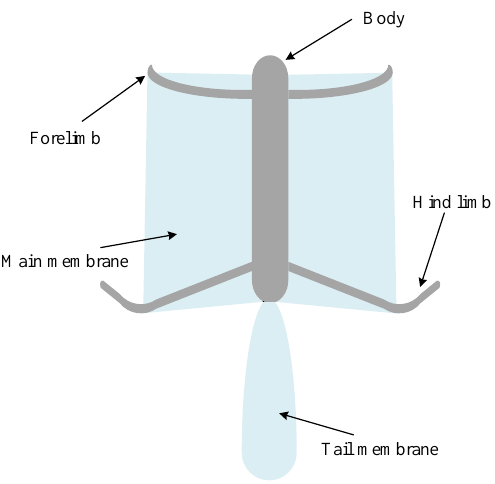
Figure 1. Structural form of flexible wing–limb blending platform.